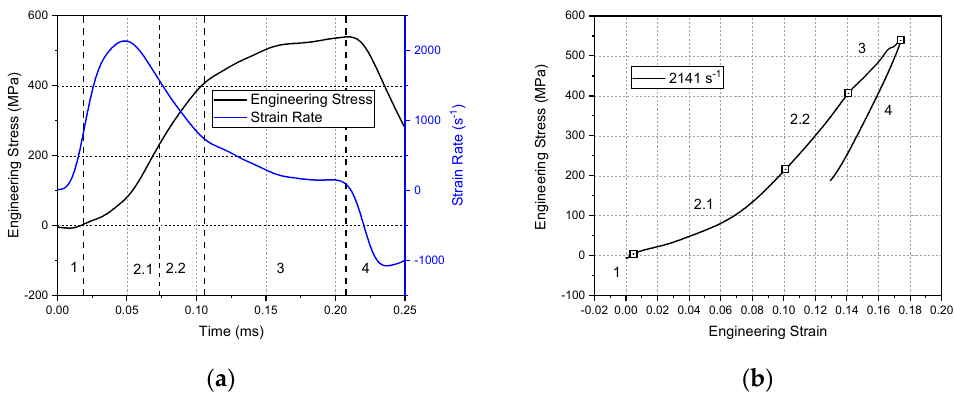
Figure 7. Evolution of the stress and strain rate curves of non-damaging test under out-of-plane loading: ( a ) stress and strain rate vs. time curves; ( b ) stress vs. strain curve.